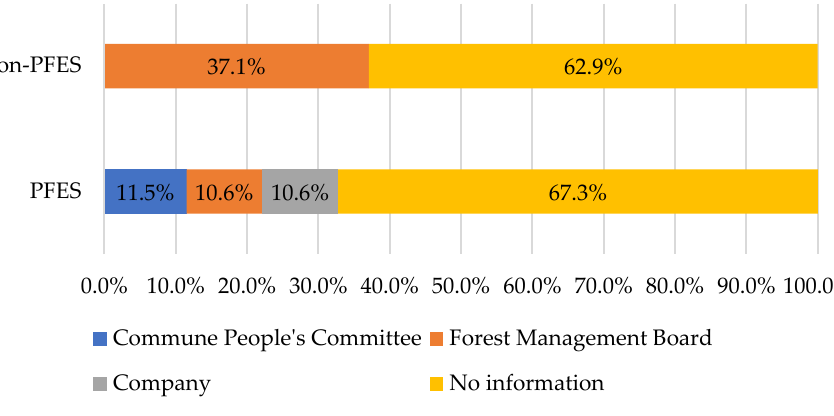
Figure 10. Ownership of encroached forest.